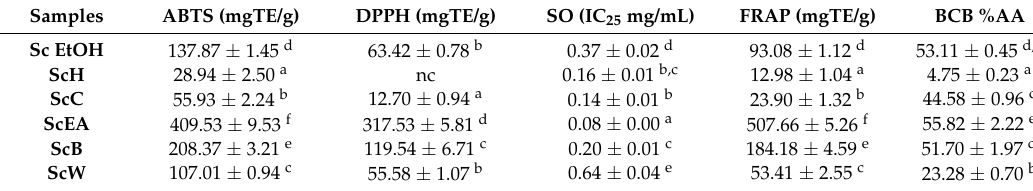
Table 1. Results of ABTS, DPPH and super oxide (SO) scavenging activity, ferric reducing antioxidant power (FRAP) and β -carotene bleaching (BCB) of S. clivicolus